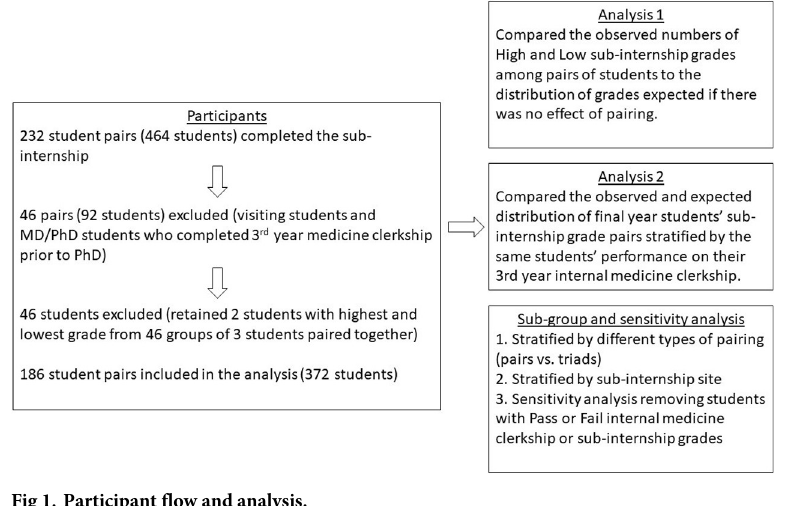
Fig 1. Participant flow and